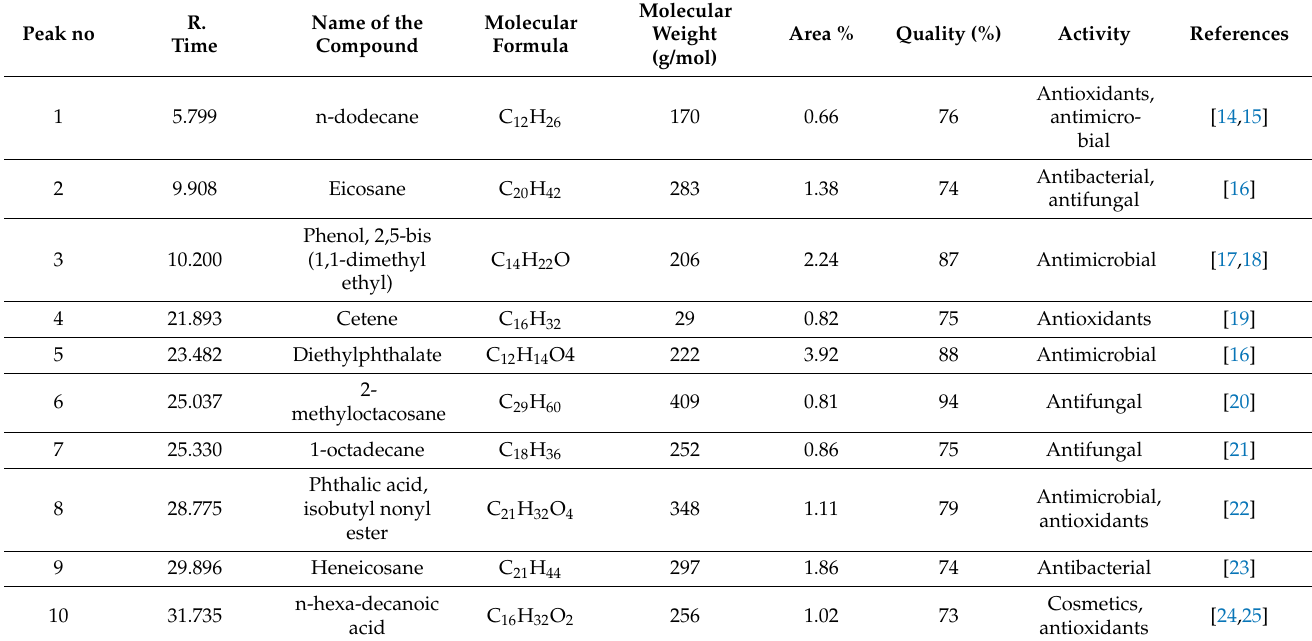
Table 2. Antimicrobial compounds identified in the ethyl acetate extract by GC-MS from fraction no. 2. R. Peak no